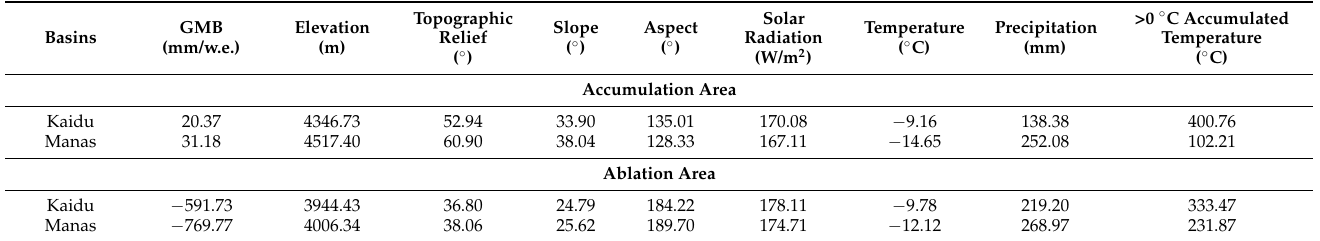
Table 4. Statistical value in the accumulation/ablation area of both